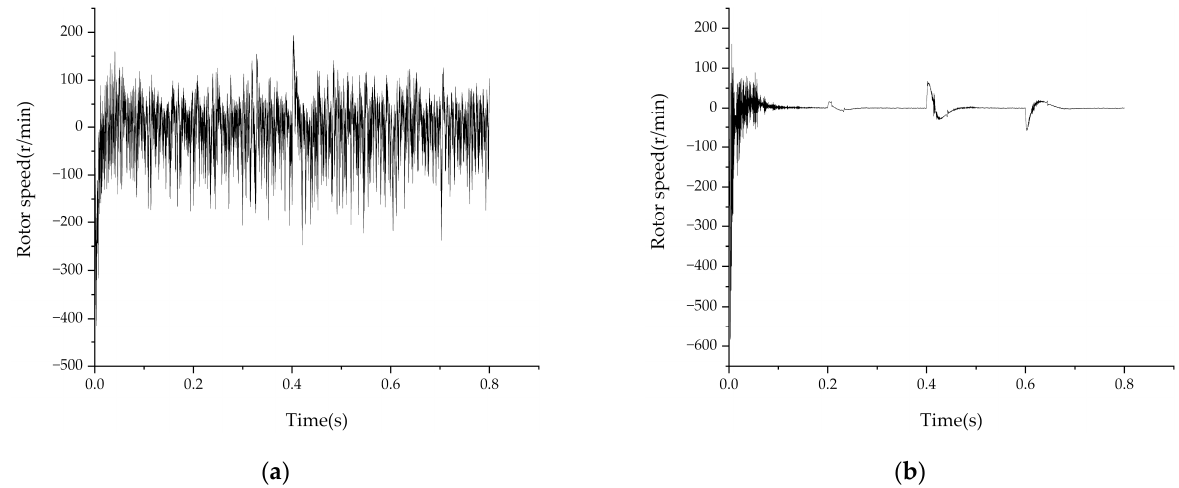
Figure 9. Experimental results of rotor speed error. ( a ) Traditional sliding mode observer, ( b ) new sliding mode observer.